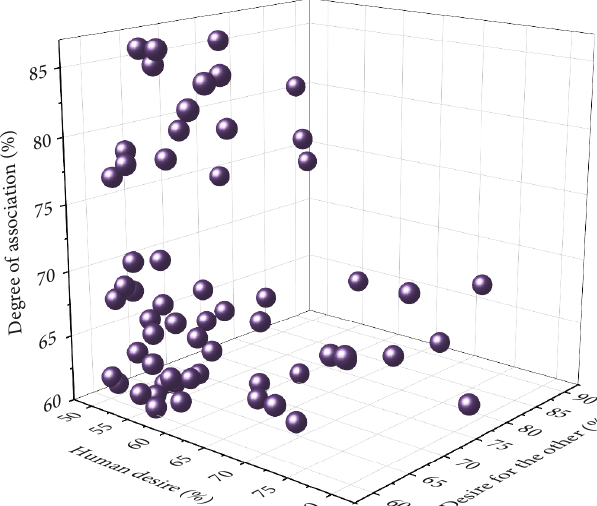
Figure 4: The correlation between human desire and the desire of the big other.